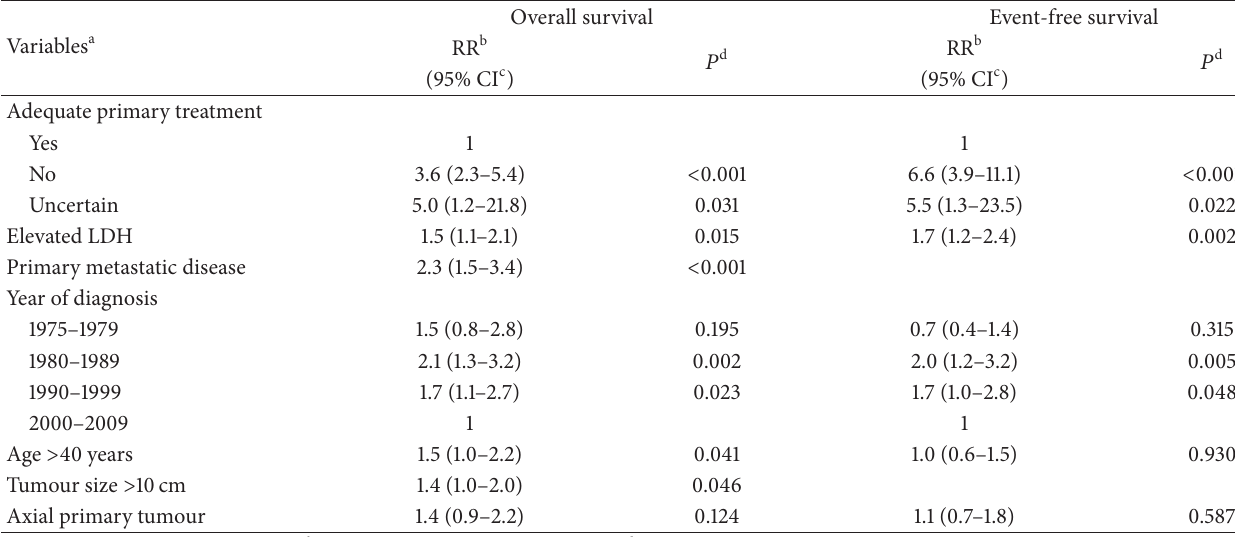
Table5:MultivariateCox-regressionanalysisofprognosticfactorsandtreatment-relatedvariablesforoverallsurvivalandevent-freesurvival. All high-grade osteosarcomas.